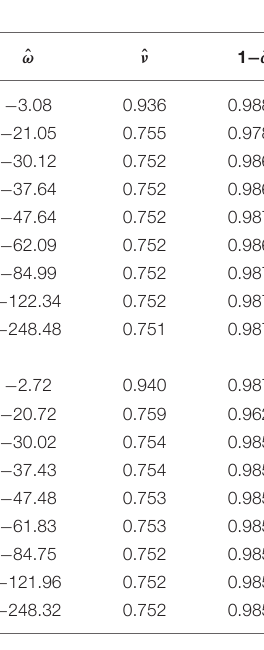
TABLE 5 | Three–stage estimation of the inverse coefficient of variation for underlying Beta ( 0.5, 0.5 ) and ( 1,1 ) m